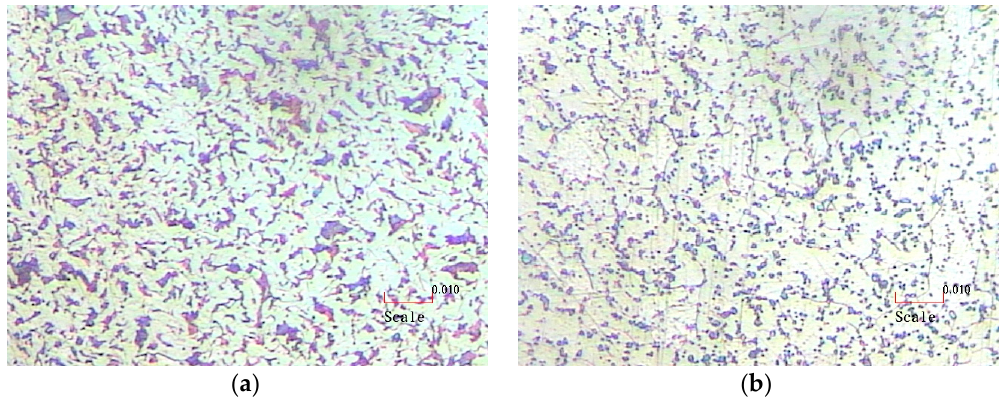
Figure 1. Microstructures of drawn AISI 1022 steel wires (×500). ( a ) Non-spheroidized; ( b ) Spheroidized. The optimum experimental results of the tensile strength and hardness (mean, µ ; standard deviation, S ; and S/N ratio) of spheroidized annealed steel wire are shown in Tables 4 and 5 respectively. The mean tensile strength varies from 368.9 to 407.0 MPa. The mean tensile strengths of tests L2, L3 and L7 are smaller than the target value, as shown in Table 4. The mean tensile strength of test L8 is very close to the target value and its standard deviation is the smallest of the nine tests. Table 4. The experimental results for tensile strength.